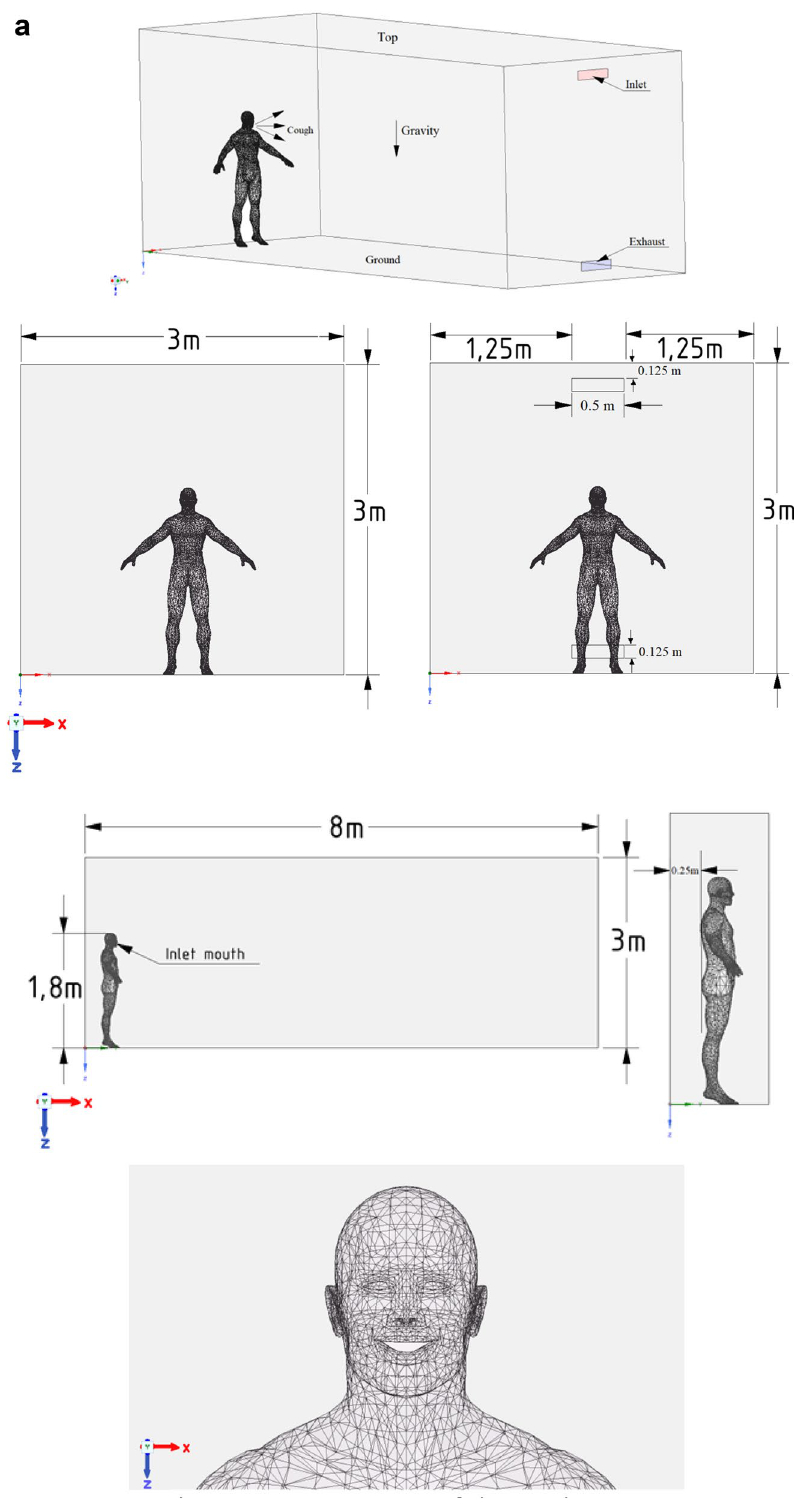
Figure 5. ( a ) Geometry of the study area. ( b ) Computational grid of the study